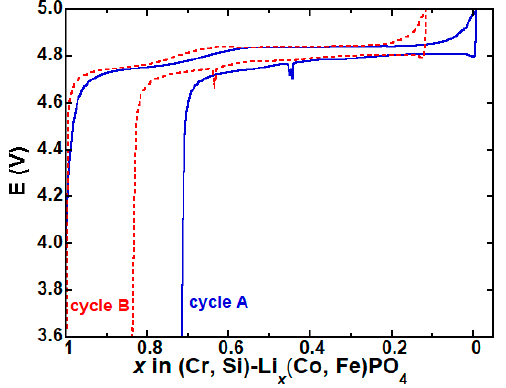
Figure 3. Variation in cell voltage vs. Li concentration during cycling.